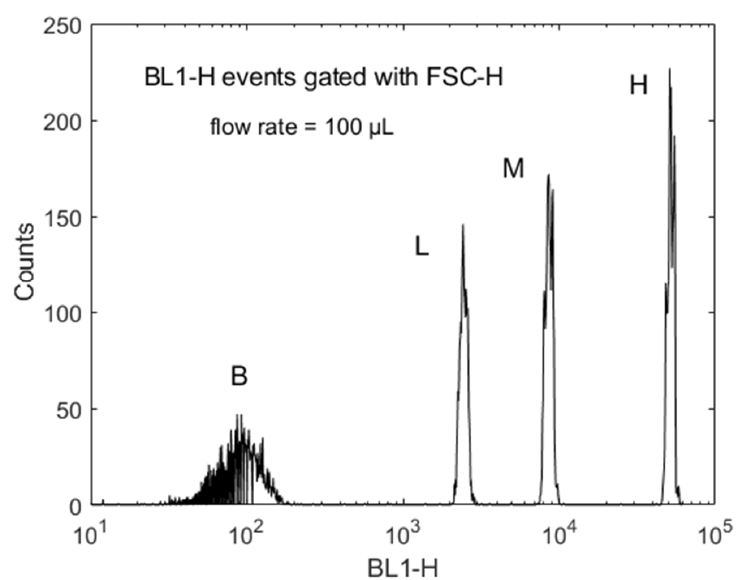
Figure 1. A histogram of the signals recorded by a flow cytometer for a sample consisting of a mixture of four multilevel beads B, L, M, and H. B stands for a blank bead, whereas L, M, and H stand for beads with low, medium, and high loading of label molecules. BL1-H is the digital representation of the height of the voltage pulses detected in the first fluorescence channel of the 488 nm laser. Counts represent the number of beads which gave a signal associated with the value on the BL1-H axis. The histogram has 512 bins along the BL1-H axis and a total of 10,000 events. The sample flow rate was 100 uL/min. Each fluorescence event was gated with a strong signal in the forward scattering channel, FSC-H. There was minimal electronic noise recorded on the histogram. The signals from all beads were large; thus, the gain was set low.